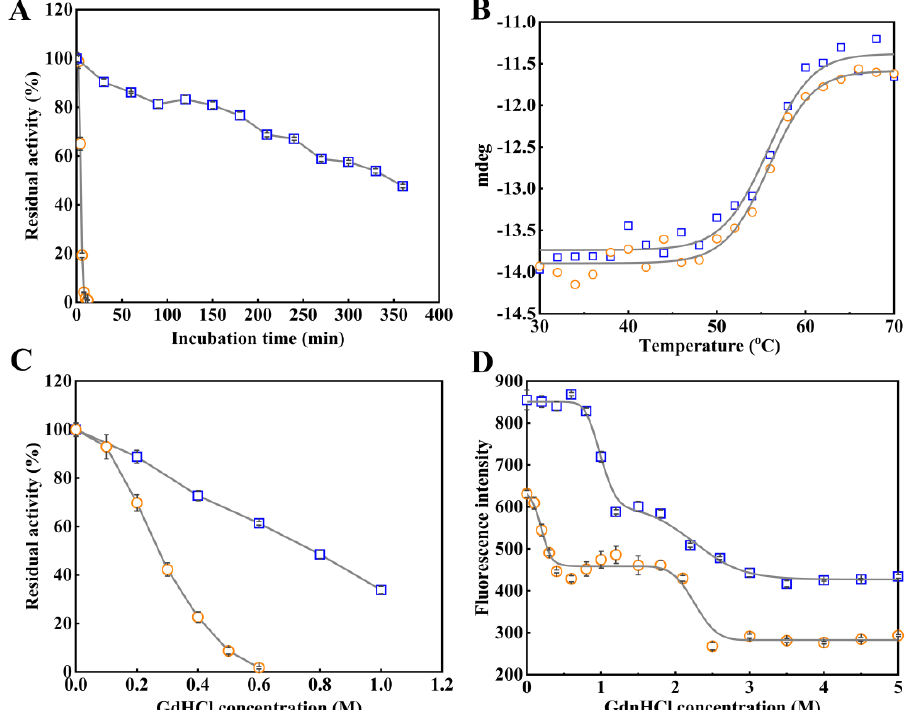
Figure 5. Thermal and chemical stabilities of arylesterase LggEst wild type and the deleted mutant. ( A ) Thermal inactivation profiles of LggEst wild type and the deleted mutant. After incubating the enzymes (1.0 mg mL − 1 ) for specified time intervals at 45 ◦ C, the residual activities were measured in 50 mM phosphate buffer (pH 7.5) at 45 ◦ C using p NPC8 as the substrate. Enzymatic activity of LggEst without incubation is taken as the 100%. All reactions were performed in triplicate, and error bars represent the standard deviations of mean. ( B ) Thermal unfolding of LggEst wild type and the deleted mutant monitored by CD scanning. Protein concentration of 1.0 mg mL − 1 was used for the analysis. Denaturizing curves were recorded from 30 ◦ C to 70 ◦ C with a rate of 1 ◦ C min − 1 . The fitted curves for protein unfolding were shown in gray solid lines. ( C ). GdnHCl − induced inactivation of LggEst wild type and the deleted mutant. After 2 h of incubation with varied concentrations of GdnHCl at room temperature, the residual activities were measured in 50 mM phosphate buffer (pH 7.5) at 45 ◦ C using p NPC8 as the substrate. All reactions were performed in triplicate, and error bars represent the standard deviations of mean. ( D ) GdnHCl − induced unfolding of LggEst wild type and the deleted mutant monitored by fluorescence spectrophotometry. The fluorescence spectra were recorded at the wavelengths between 300 and 400 nm with an excitation wavelength at 290 nm under a scanning speed of 1200 nm min − 1 . The fitted curves for protein unfolding were shown in gray solid lines. The measured data for LggEst wild type and the deleted mutant are shown in blue square and orange circle,